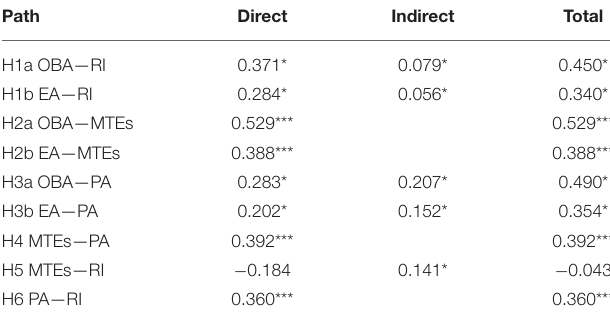
TABLE 2 | Discriminant validity of the variables. Variable